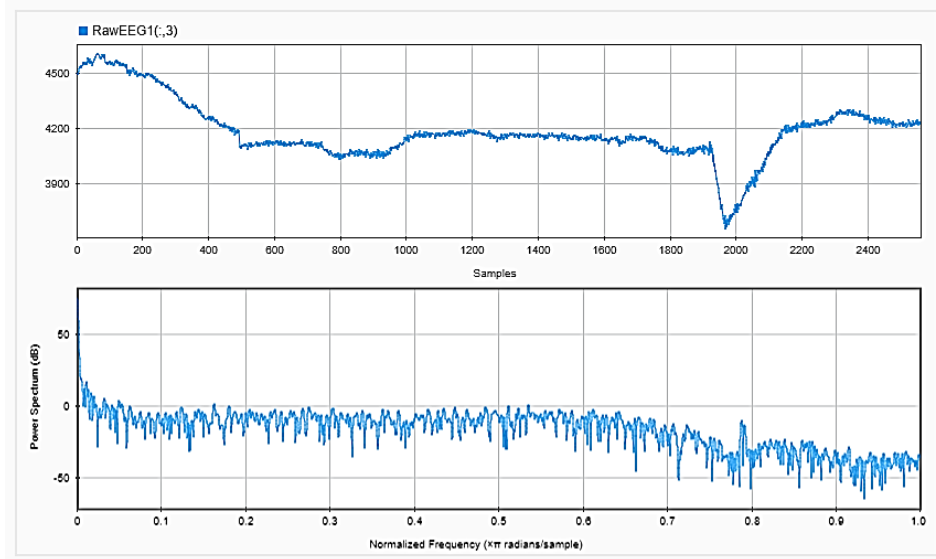
Figure 5. Raw EEG signals for one channel ( upper ), with its power spectral density (PSD) ( lower